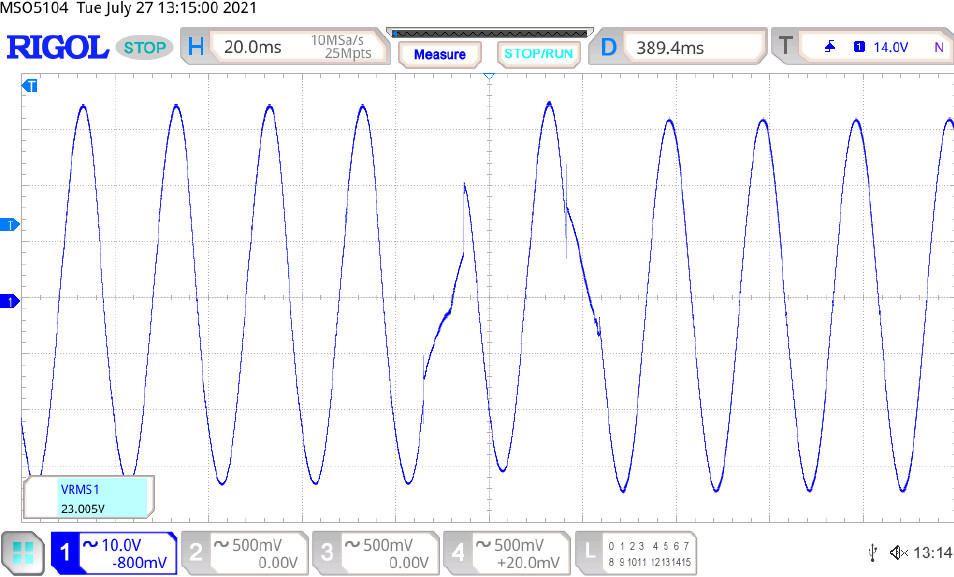
Figure 13. The transition from grid synchronization mode to islanded mode.